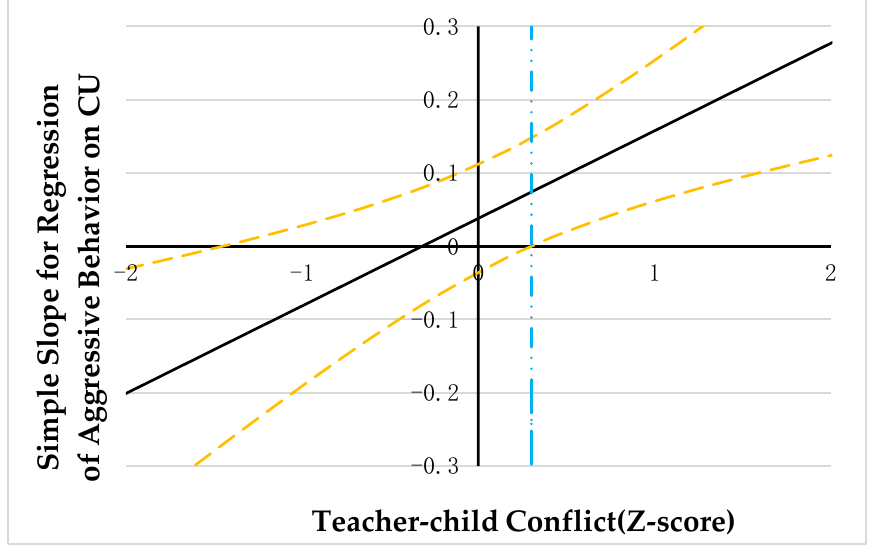
Figure 2. Johnson-Neyman regions of significance and confidence bands for mother-rated CU traits along teacher-child conflict in relation to aggressive behavior. Note. Solid diagonal line represents the regression coefficient for CU along with teacher-child conflict. Dashed diagonal yellow lines are confidence bands — upper and lower bounds of 95% confidence interval for CU coefficient along teacher-child conflict. The dashed vertical blue line indicates the point along teacher-child conflict at which the CU regression coefficient transitions from nonsignificance (left of the dashed vertical line) to statistical significance (right of dashed vertical line). The value of the dashed vertical line is 0.30.